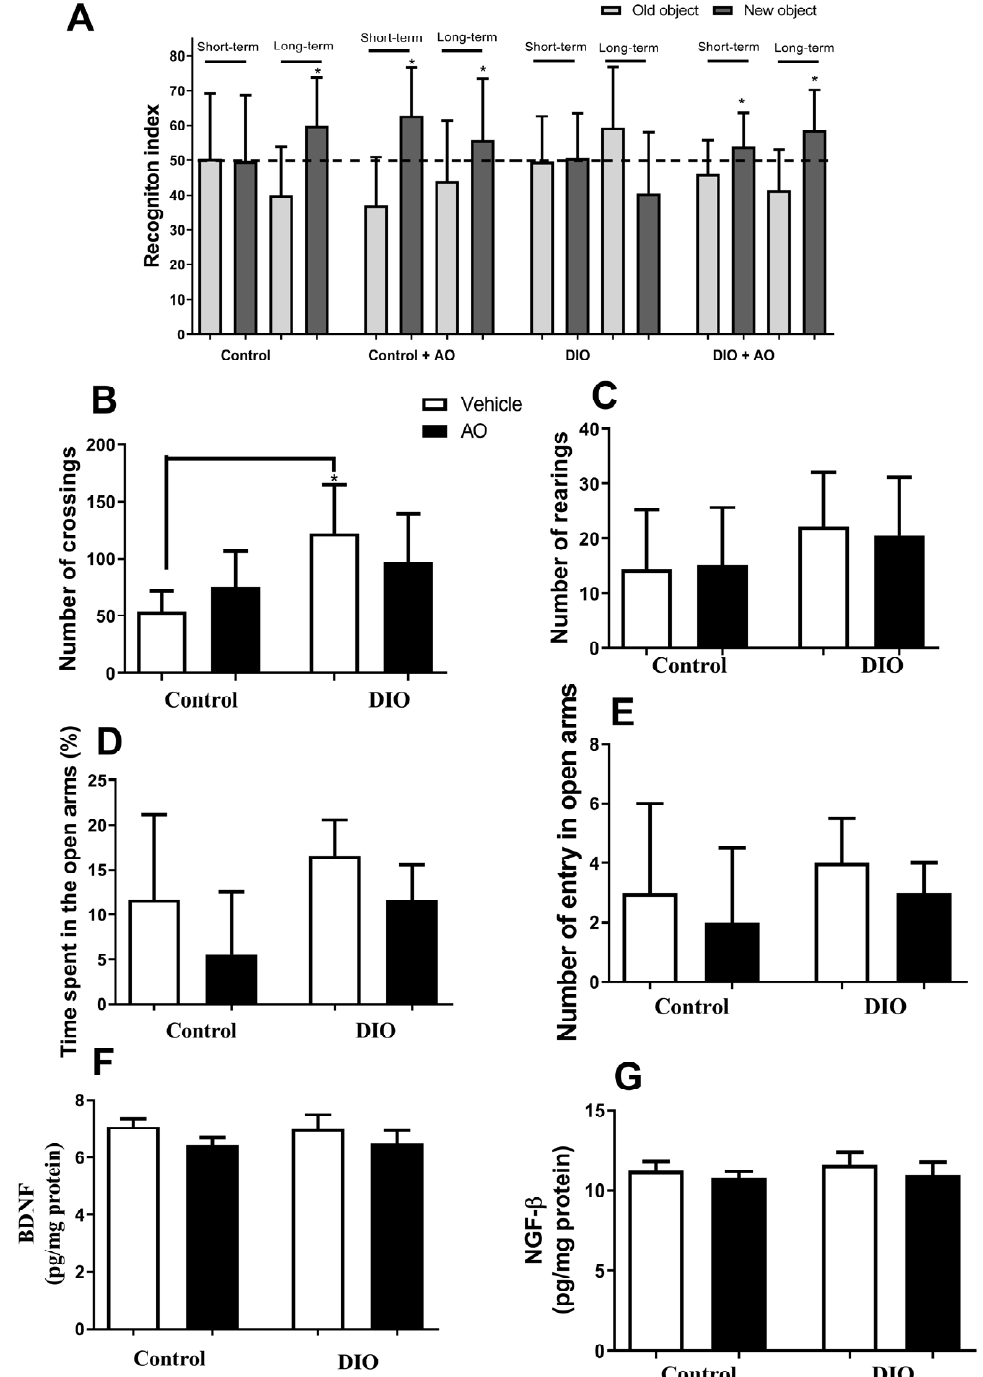
Figure 3. Effects of avocado oil (AO) supplementation on cognitive performance and mood parameters. ( A ) Recognition memory (* index recognition, new object > old object). ( B ) Number of crossing (* DIO > control, p < 0.05). ( C ) Number of rearings. ( D ) Time spent in the open arms. ( E ) Number of entries in open arms. ( F ) BDNF level in the hippocampus. ( G ) NGF- β level in the hippocampus. The results